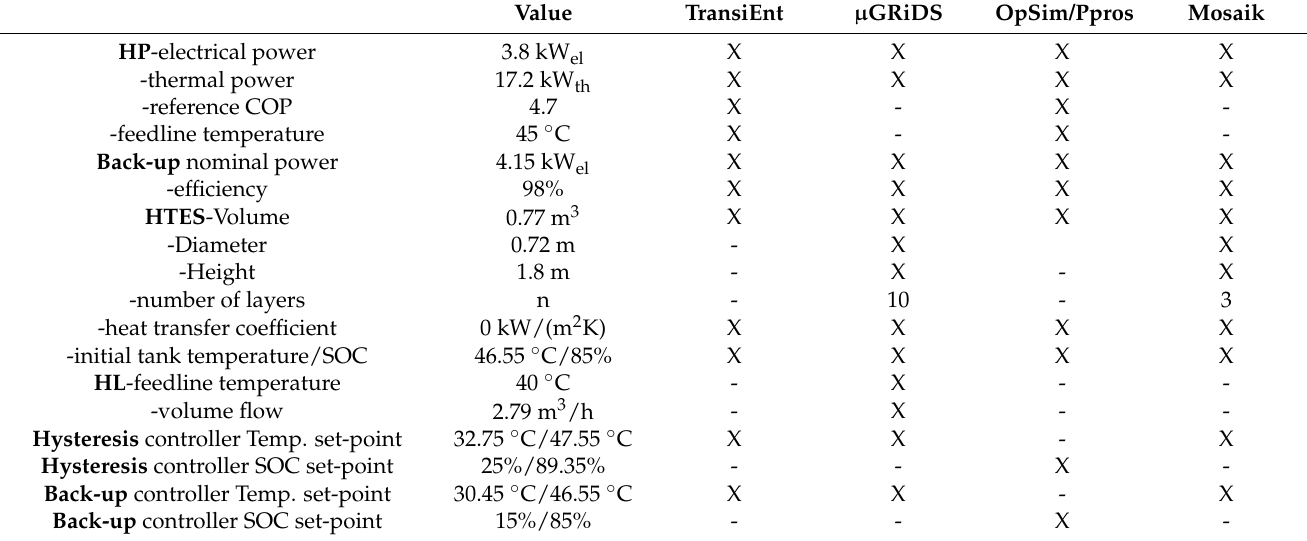
Table 6. Main parameters used for the simulation of HP scenario. “X” denotes a check mark when the parameter is implemented in the corresponding